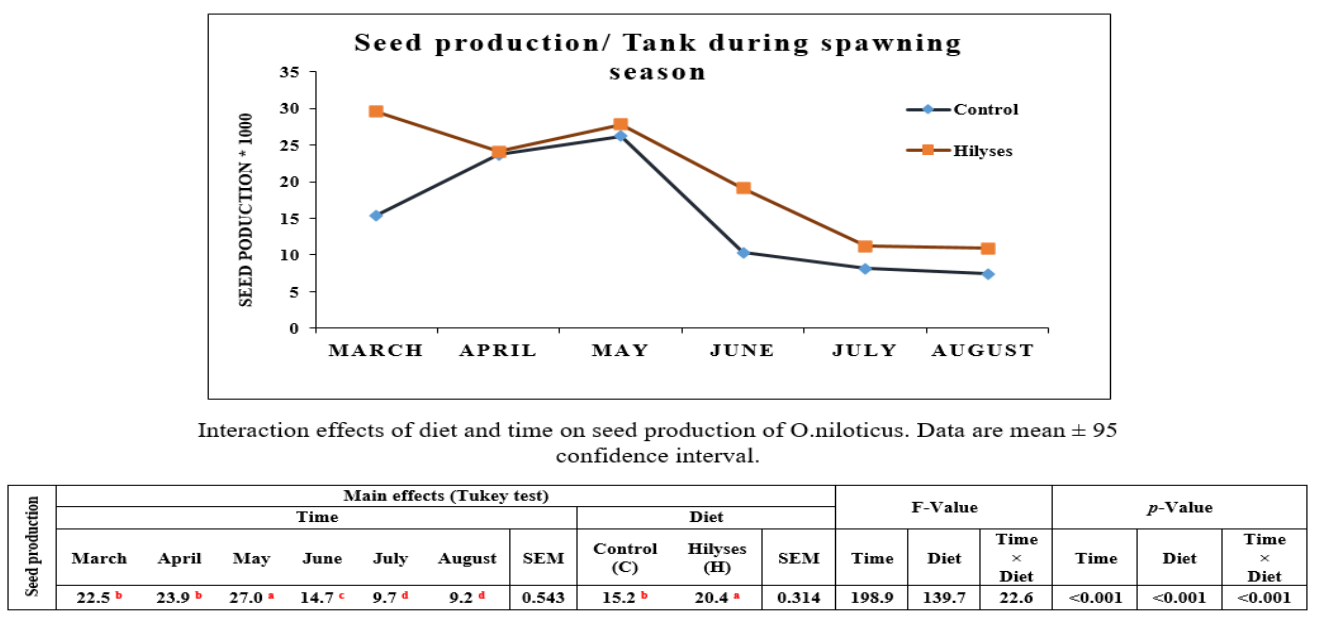
Figure 2. Seed production in tilapia broodstock fed a Hilyses (H) and basal diet (C) during the spawning season from March to August. The cement tank area was 3 × 8 m 2 stocked with 40 females/16 males in each tank ( n = 11 tanks), Temp. = 30 ± 1 °C, pH = 8.6 ± 0.2. The results were statistically analyzed using two-way analysis of variance (ANOVA) with type of diets and time as factors, followed by Tukey’s HSD test for mean multi-comparison test. Significance was determined at p < 0.05. a, b ,c, d Means within a row with different superscripts are significantly different (P ˂ 0.05).